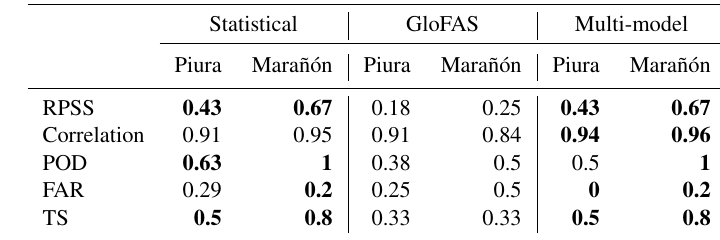
Table 5. Mean RPSS, Pearson correlation coefficient, POD, FAR, and TS for each location and forecast approach. Bold text indicates best score per metric per site (ties between two models are both